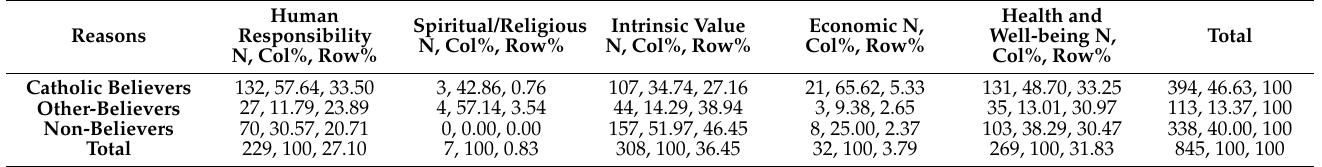
Table A4. Cross-table religious groups and main motivation to conserve